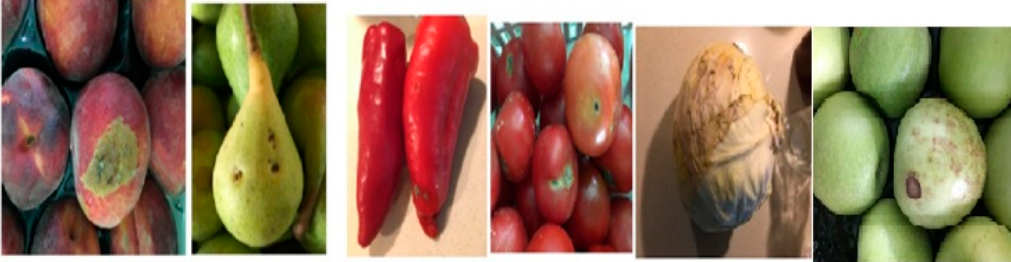
Figure 1. Photos of the samples. Their quality was reasonably good and they were chosen for their slight lesions and minor skin ruptures in order to isolate pathogens and spoilage